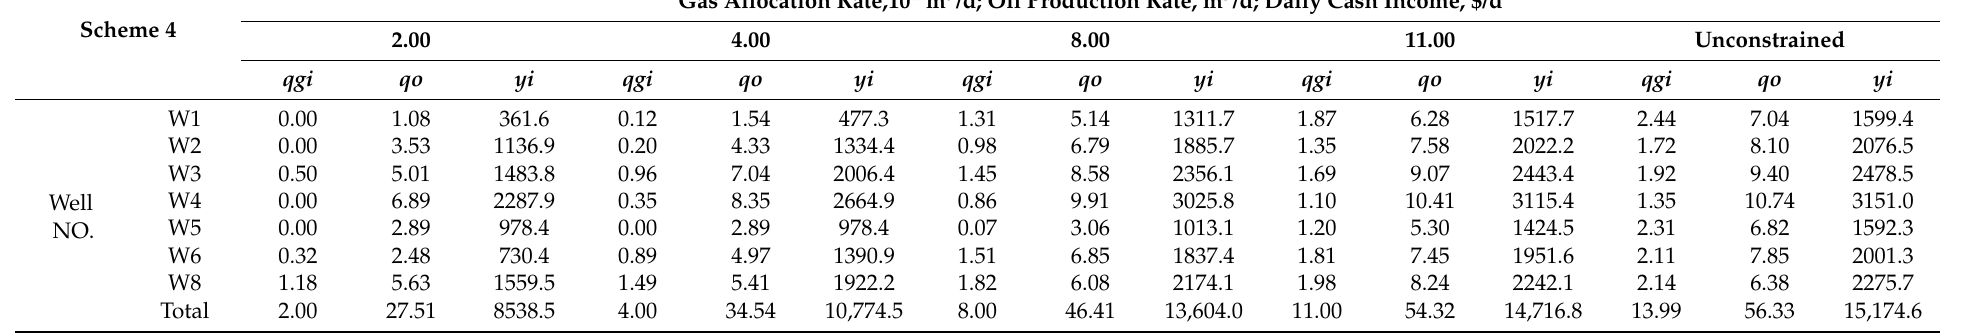
Table 11. Gas allocation result of various injected gas rate of Scheme